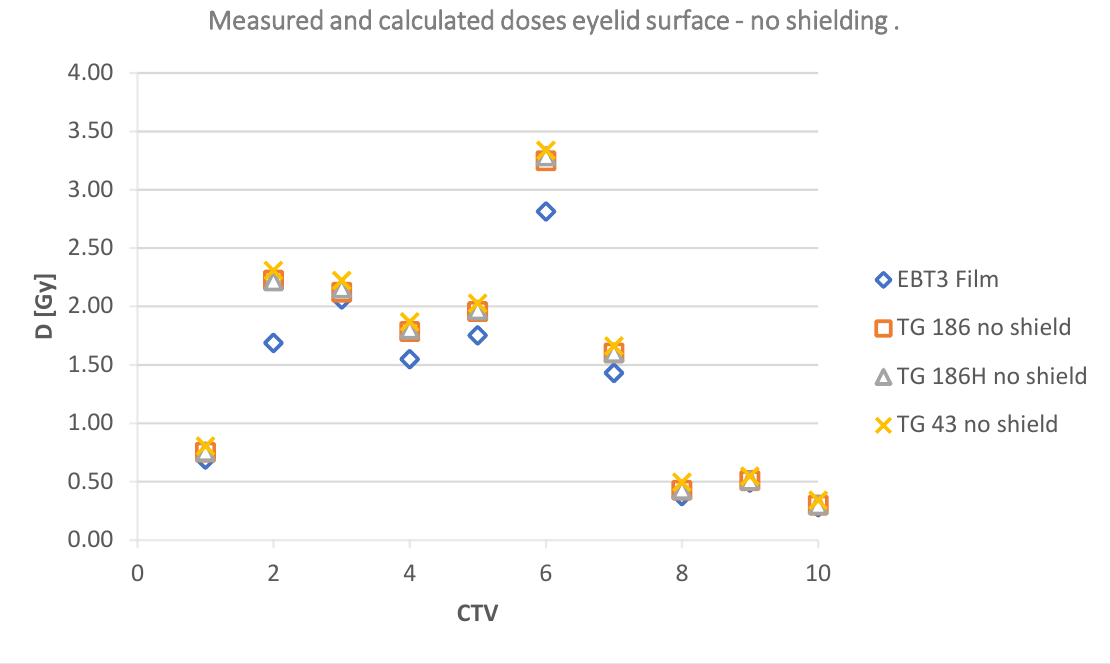
Figure 15. Doses at a point in the center of the lens of the eye without a shielding.